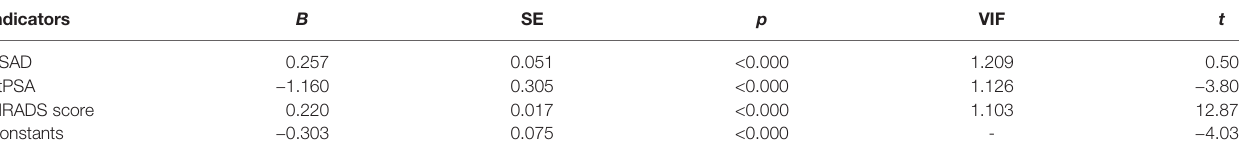
TABLE 3B | Multivariate stepwise logistic regression analysis for predicting csPCa in the training group. Indicators B SE p